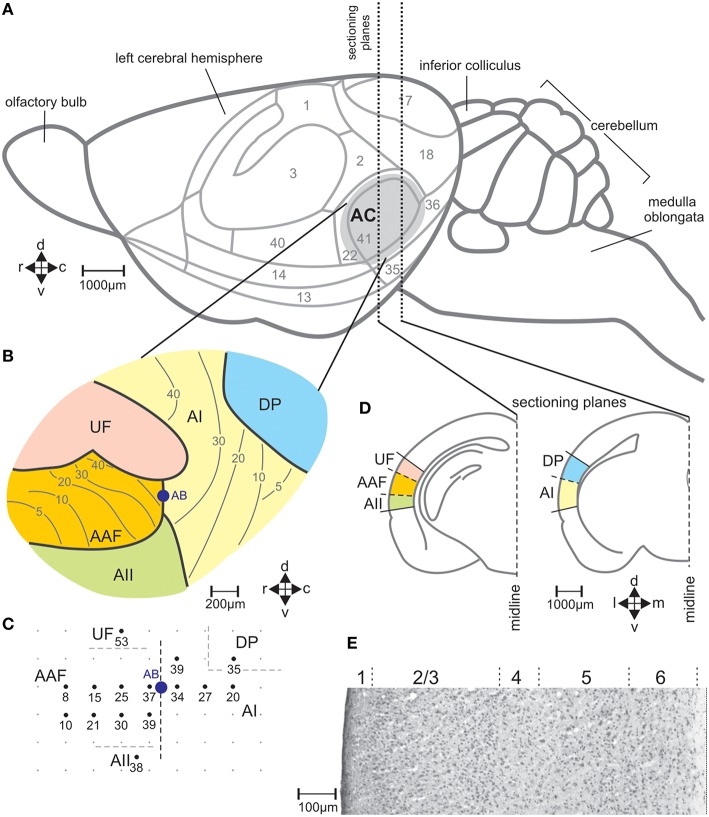
The auditory cortical fields of the mouse brain. (A) View on the left side of the brain with cytologically defined areas (Caviness, 1975) and the auditory cortex (AC) marked in gray. (B) Division of the AC in the fields AI, primary field; AAF, anterior field; UF, ultrasonic field; AII, secondary field; DP, dorsoposterior field, with the general tonotopic gradients in AI and AAF indicated by lines and the corresponding characteristic frequencies (kHz) (Stiebler et al., 1997). (C) Example of a map of electrophysiologically measured characteristic frequencies (kHz) of neurons at the indicated locations in the AC. AB shows the location at the border between AI and AAF where alcian blue was injected as reference in the brain sections for field assignment. (D) Two frontal sections through planes of the left-hemisphere AC with the positions of the indicated fields of the AC. (E) Sample section through AI stained with cresyl violet with indicated layers 1–6. c, caudal; d, dorsal; r, rostral; v, ventral.